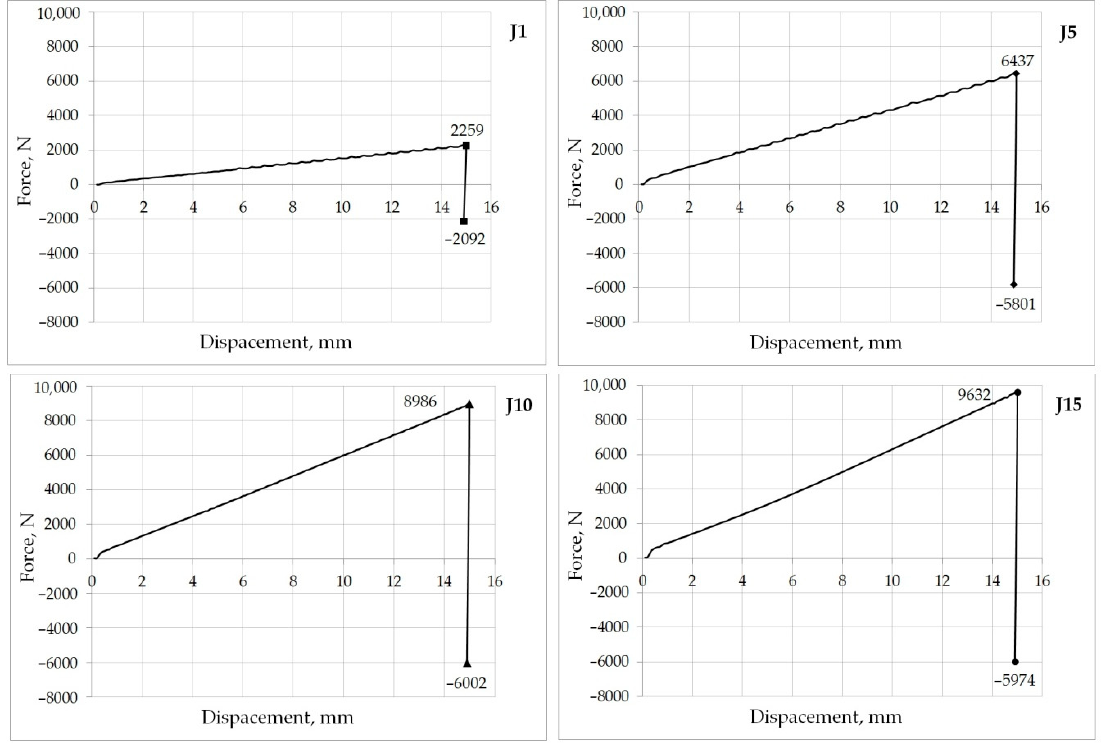
Figure 9. Values of total strains.